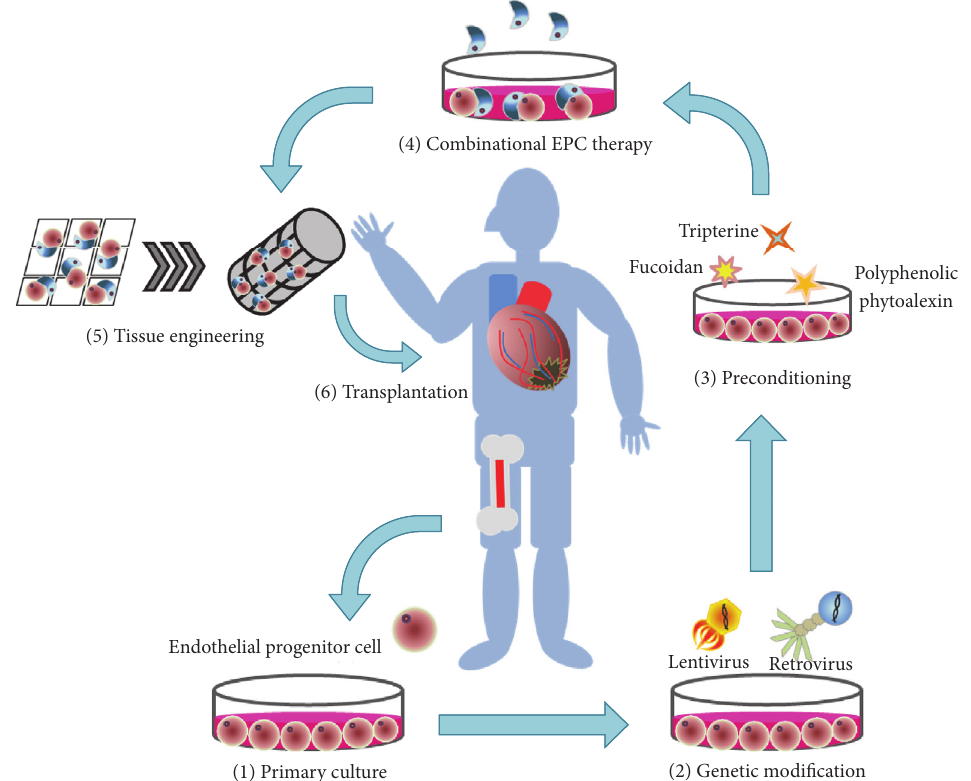
Figure 2: Promising therapeutic strategies for EPC therapy. Multistep combinational therapeutic strategies of EPC therapy against CVDs include the following: (1) patient-derived EPCs are isolated from healthy tissue; ((2), (3), (4)) improvement in EPC bioactivities via genetic modifications or pretreatment with natural compound or cocultured with other stem cells, such as MSCs and CPCs; and ((5), (6)) tissue engineering techniques using biomaterials protect cells from the harsh conditions of ischemic